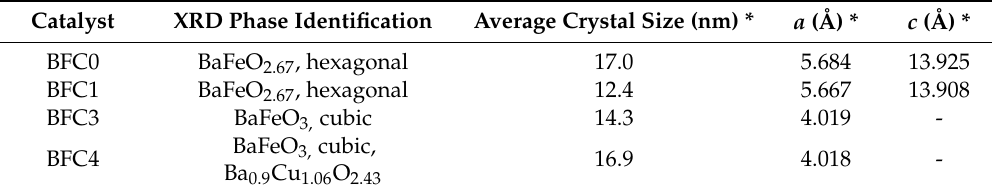
Table 2. XRD characterization data of BaFe 1 − x Cu x O 3 catalysts.